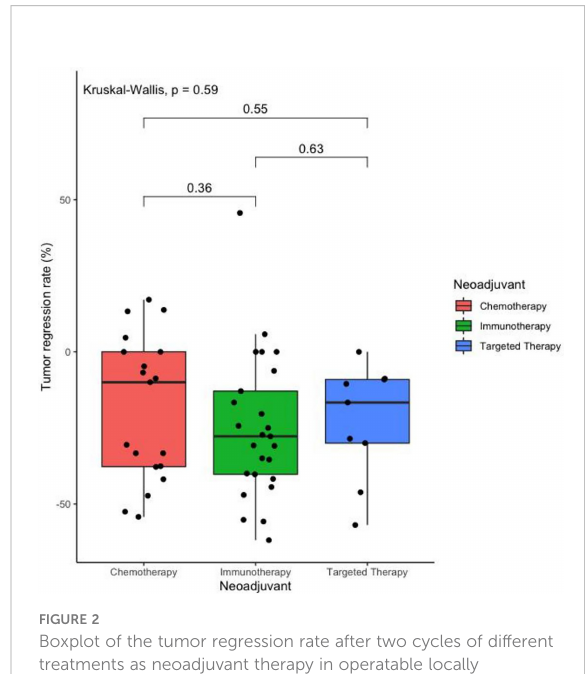
FIGURE 2 Boxplot of the tumor regression rate after two cycles of different treatments as neoadjuvant therapy in operatable locally advanced NSCLC. (N =